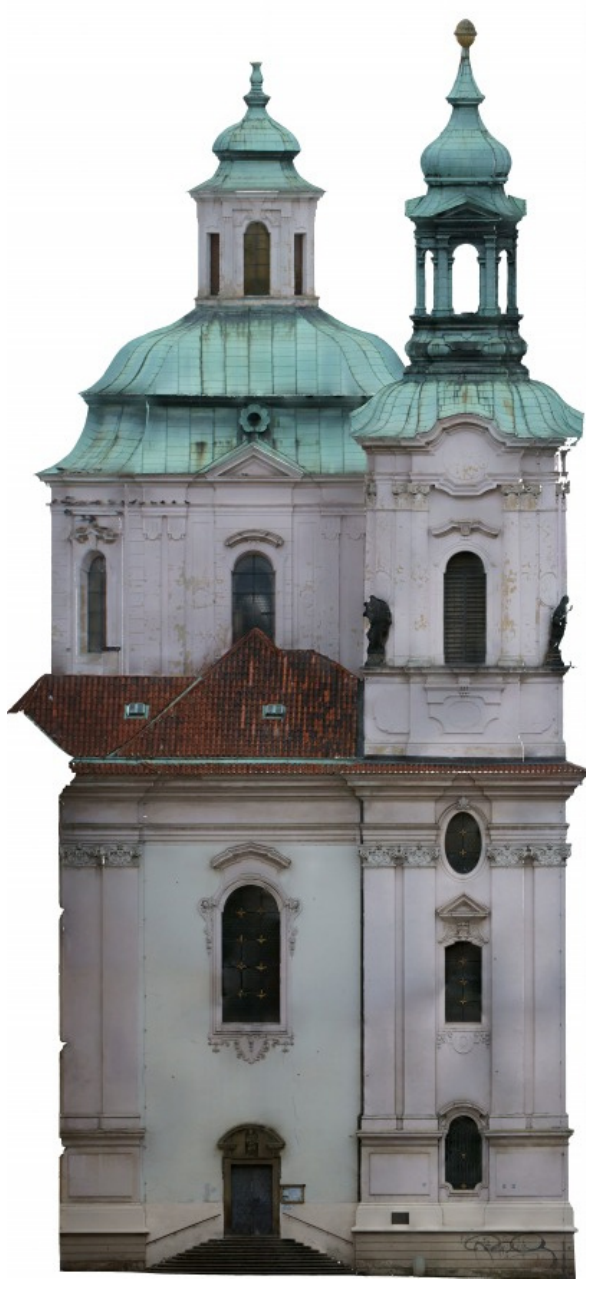
Figure 7. Orthophoto of west facade If you get to the pixel level (pixel size is 5 mm), you can see differences in quality of details e.g. on window decoration or on roofing see Fig. 8 and Fig. 9. That’s why we used “Mosaic” method which is of a better